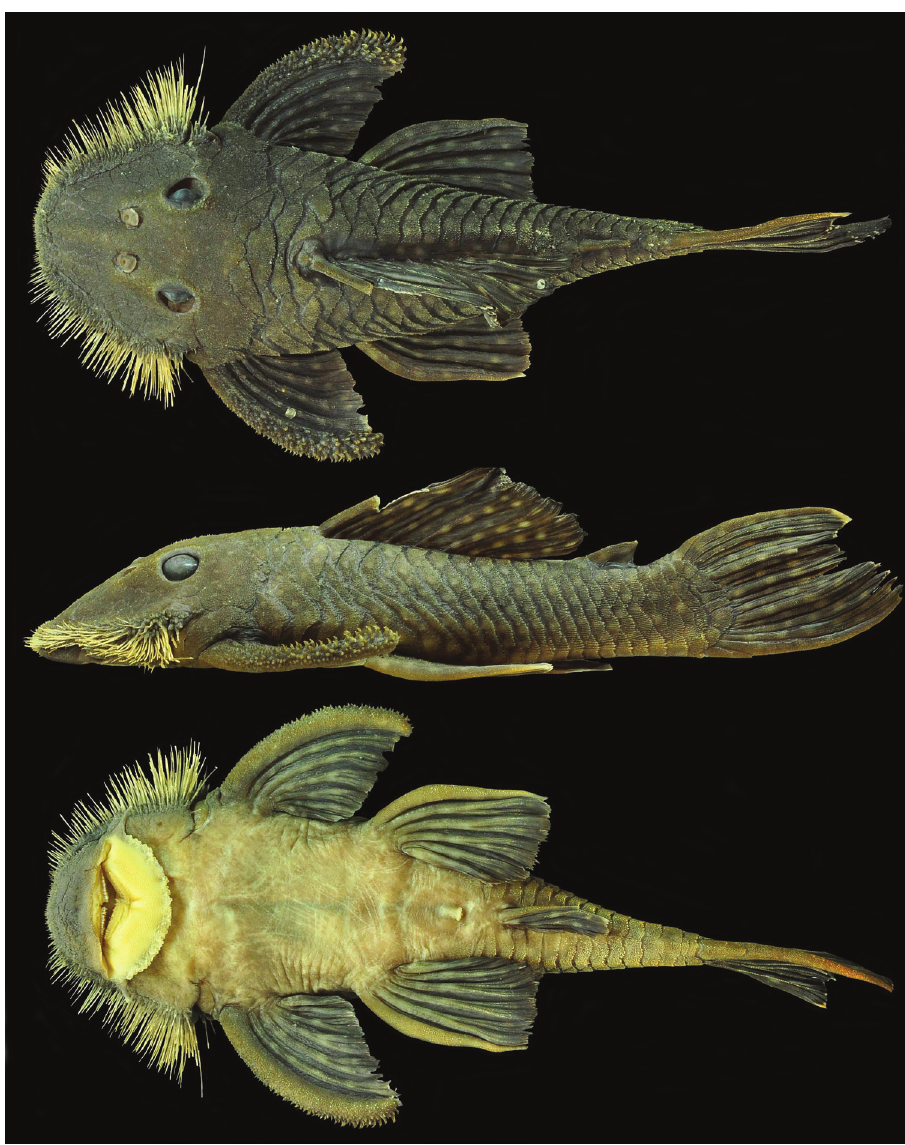
Figure 1. Pseudancistrus zawadzkii , MZUSP 115056, holotype, male, 116.4 mm SL; Pará State, Tapajós river basin, Paratypes. Brazil: Pará State: municipality of Itaituba: LBP 15045 (2 females,